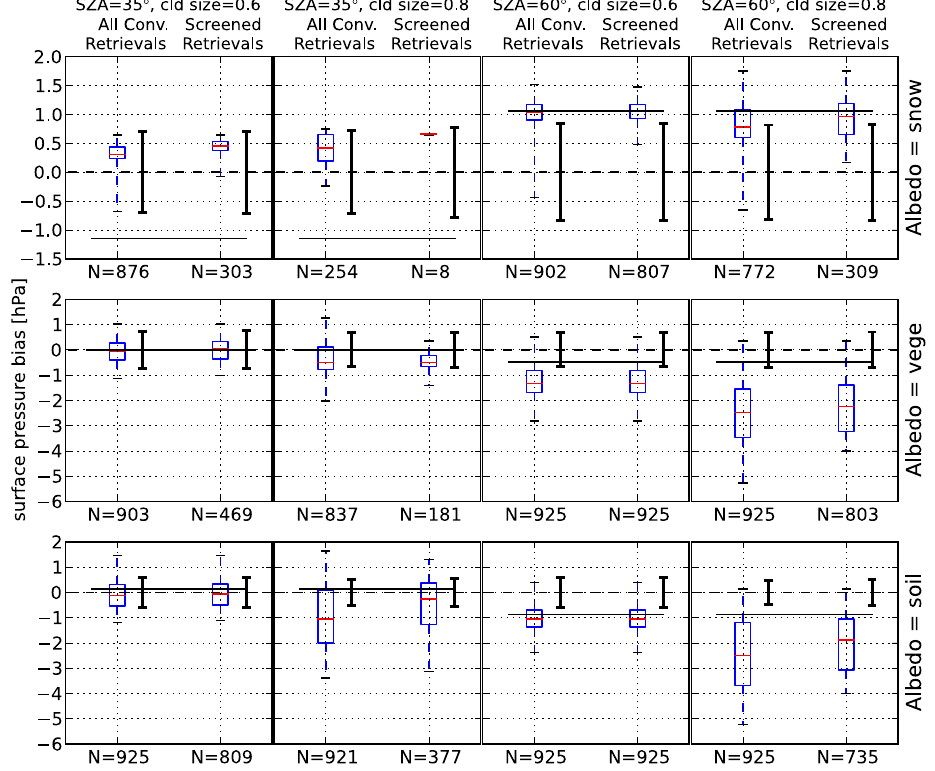
Figure 12. Summary of surface pressure retrieval bias for all scenarios with 0.6 and 0.8km clouds, with the same layout as Fig.